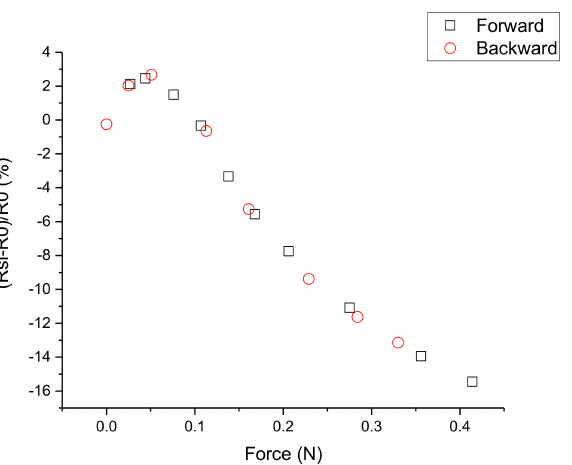
Figure 16. Relative change in R SI vs. applied force. Measurement points taken in forward (force increase) and backward (force decrease) directions are shown with different